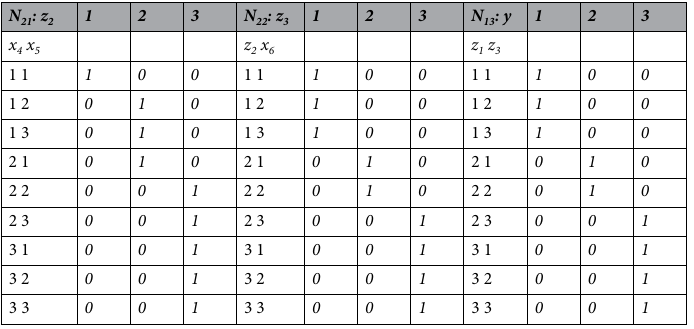
Table 4. Example of Rule bases of N 21 , N 22 and N 13